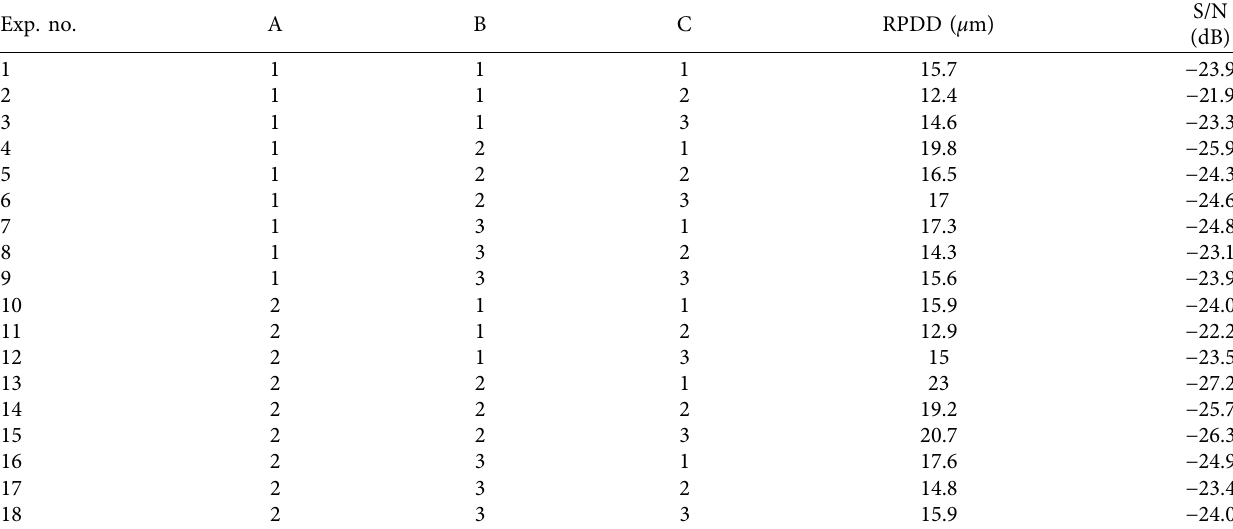
Table 5: Experimental results and S/N.